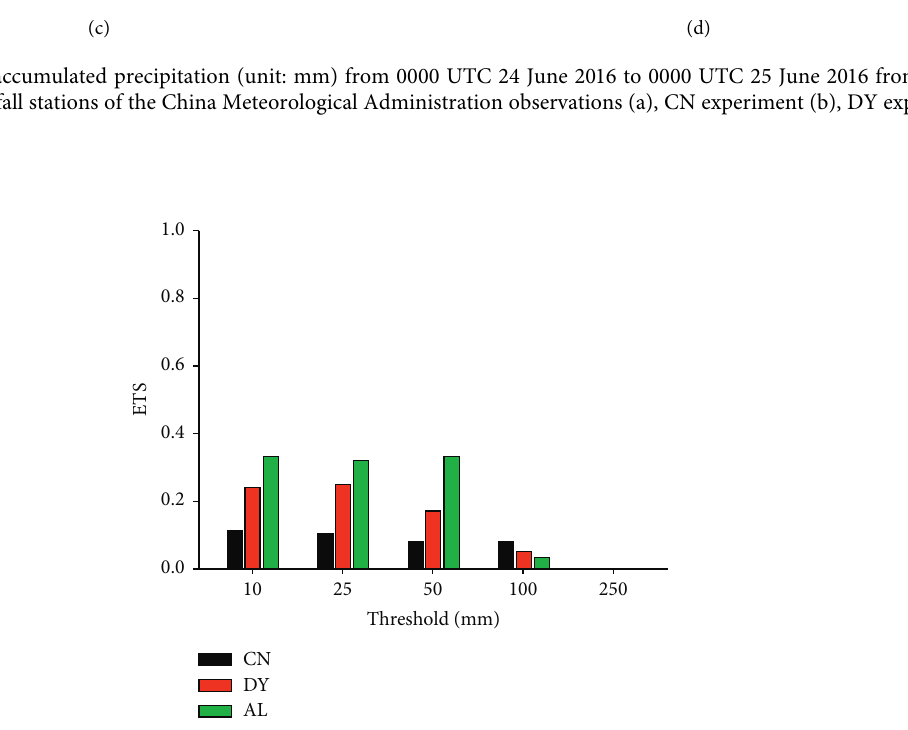
Figure 8: The ETSs of the 24-hour accumulated precipitation from 0000 UTC 24 June 2016 to 0000 UTC 25 June 2016 for the CN (black), DY (red), and AL (green) experiments at 10, 25, 50, 100, and 250mm rainfall thresholds. The calculation area is the Yangtze River displayed in Figure 6(a) with a red-dashed line